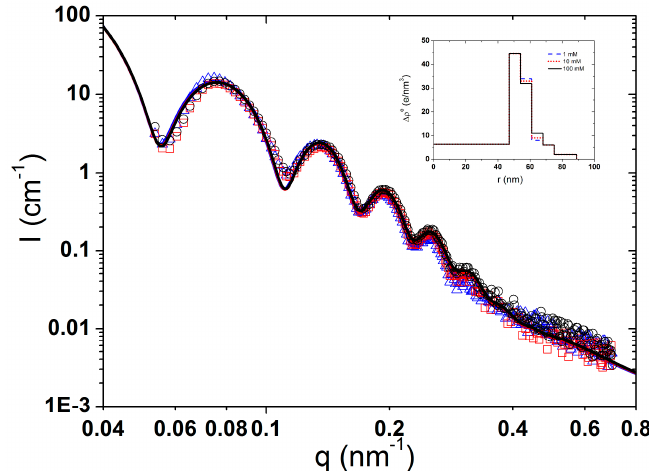
Figure 10. Scattering intensity curves of PAA-PAH double-layer modified SPBs at different ionic strengths. Symbols denote: ( ○ , black) 100 mM, ( □ , red) 10 mM, and ( ∆ , blue) 1 mM. Solid lines are the SAXS fitting data. The inset is the radial profile of excess electron density.